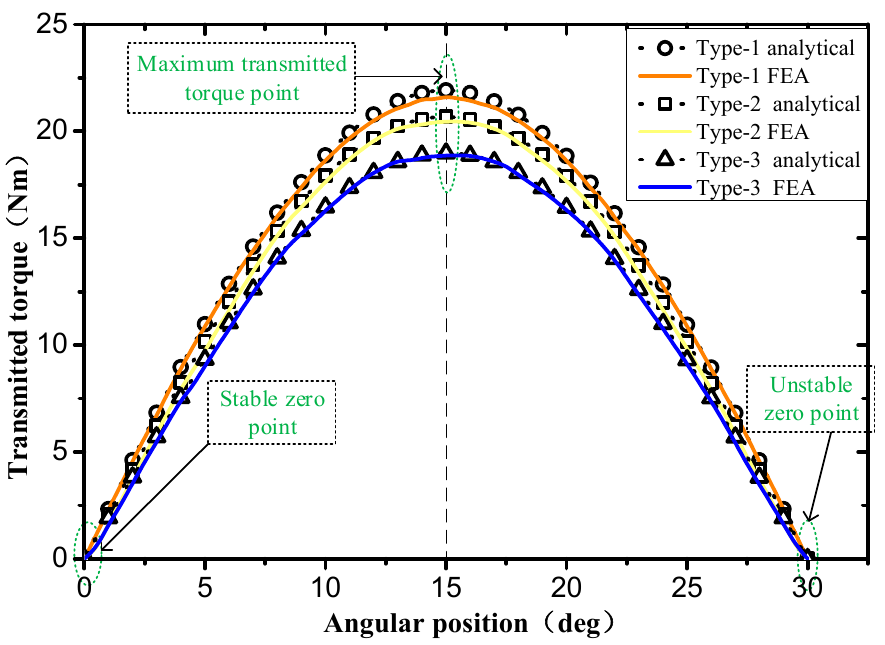
Figure 6. Comparison of analytical results and FEA results for transmitted torque of three HPMCs.